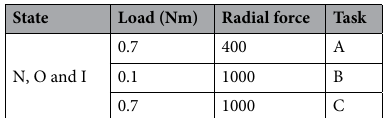
Table 6. The three tasks in KAt bearing dataset (1500 rpm).